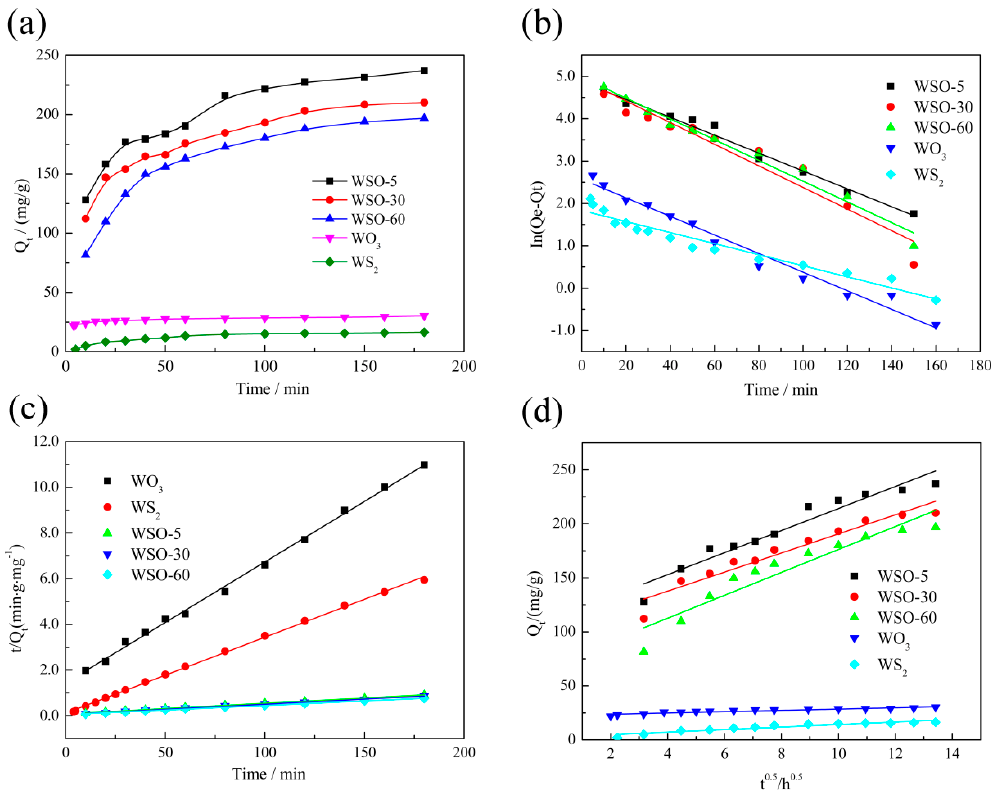
Figure 7. ( a ) The effect of the contact time on the adsorption capacity of WS 2 , WS 2 /WO 3 , and WO 3 for RhB; the fitted kinetic data with ( b ) the pseudo-first-order model, ( c ) pseudo-second-order model, and ( d ) Weber-Morris model.